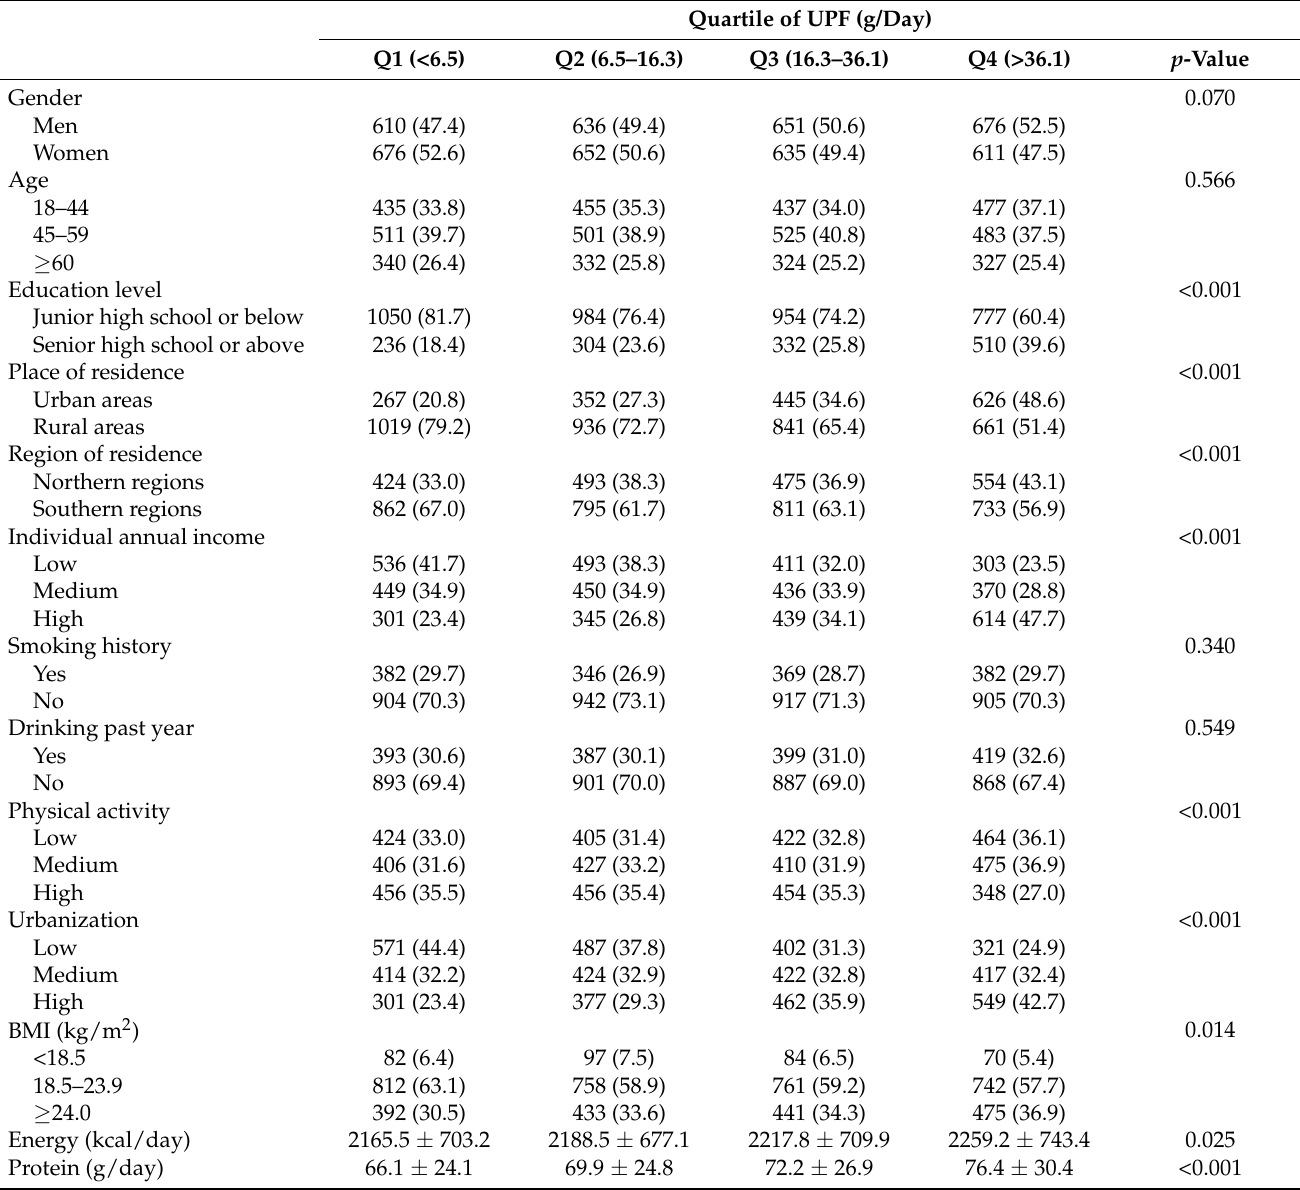
Table 1. Basic characteristics of participants by quartile of UPF